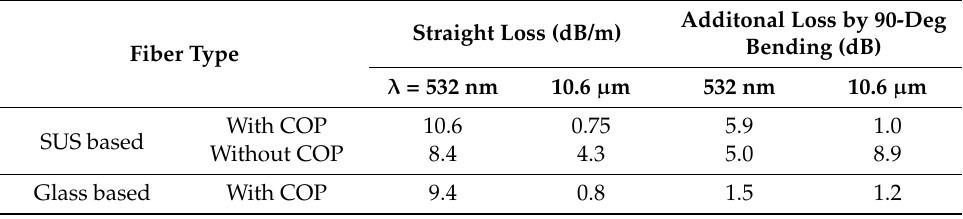
Table 1. Measured losses of SUS-based and glass-based hollow optical